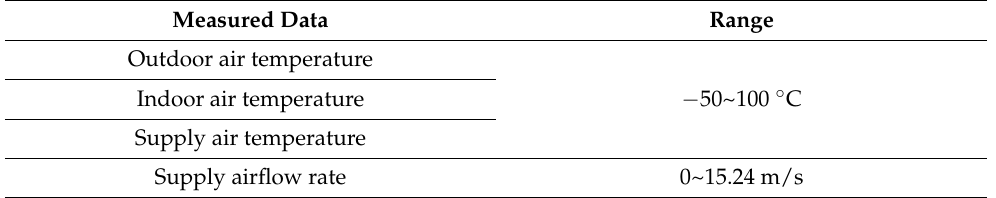
Table 3. Specification of the selected sensor.